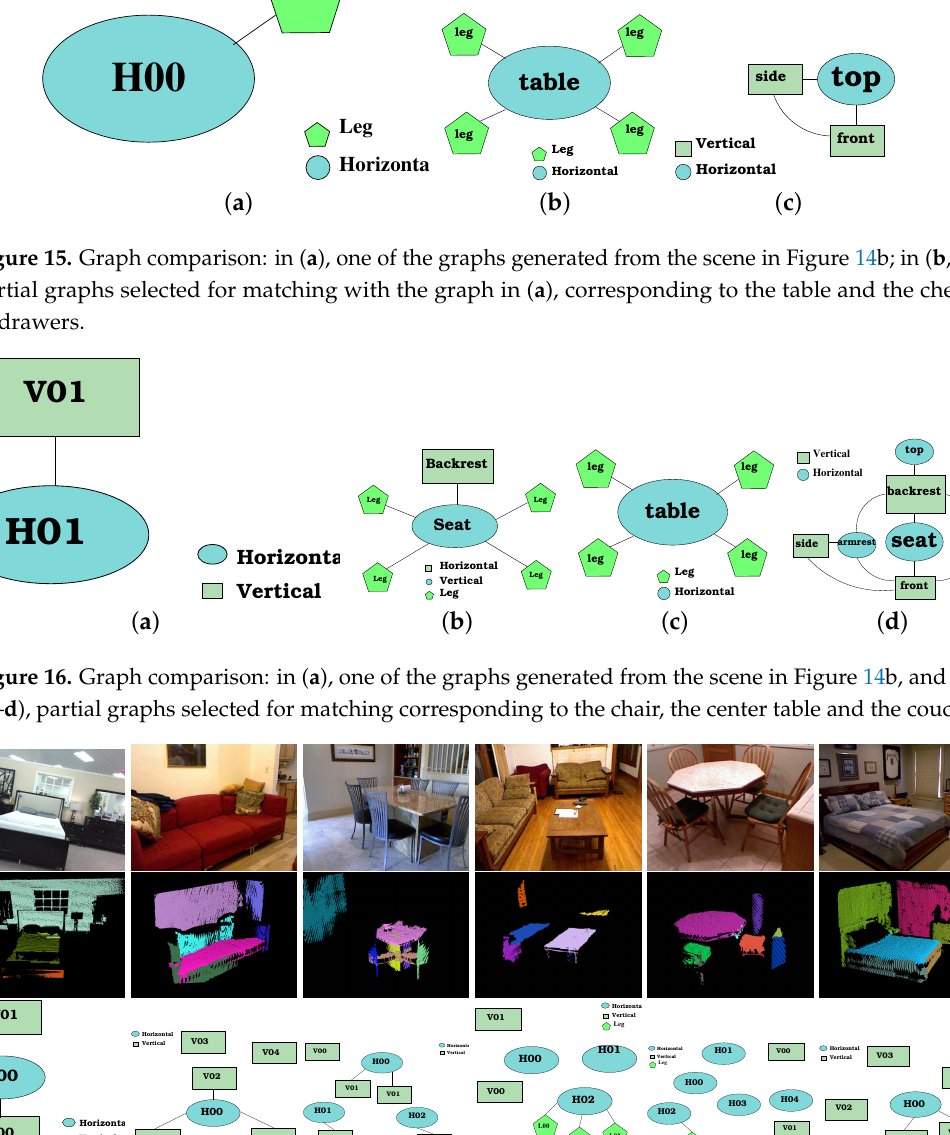
VerticalHorizontal Figure 17. Tests over images from the dataset SUNRGB-D [23]: at the top, the RGB images, in the middle, the corresponding extracted geometrical components, and at the bottom, the corresponding